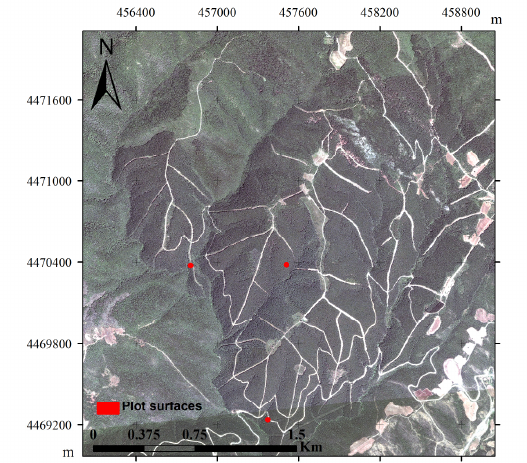
imagery (RGB=3/2/1 bands). Plot number (stand number)